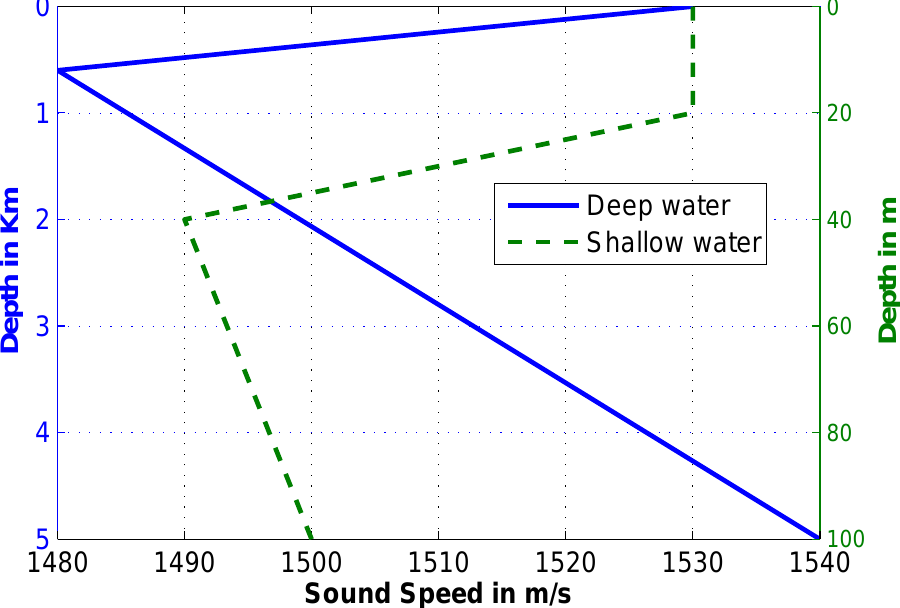
Figure 7. Sound speed profile for deep and shallow